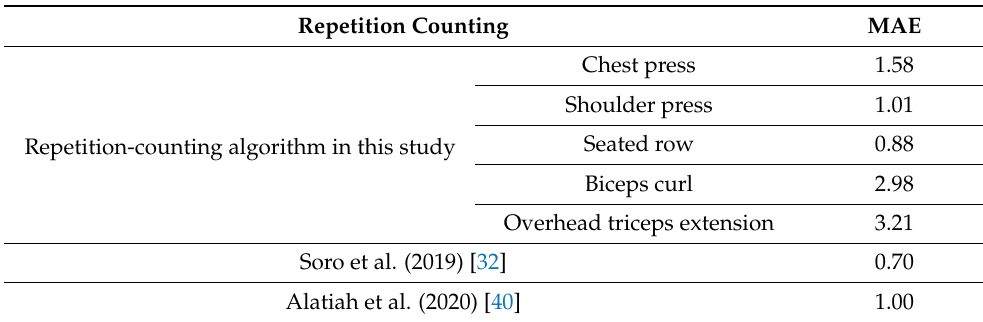
Table 16. MAE values of repetition-counting algorithm in this study and comparison with other studies [32,40]. Repetition Counting MAE